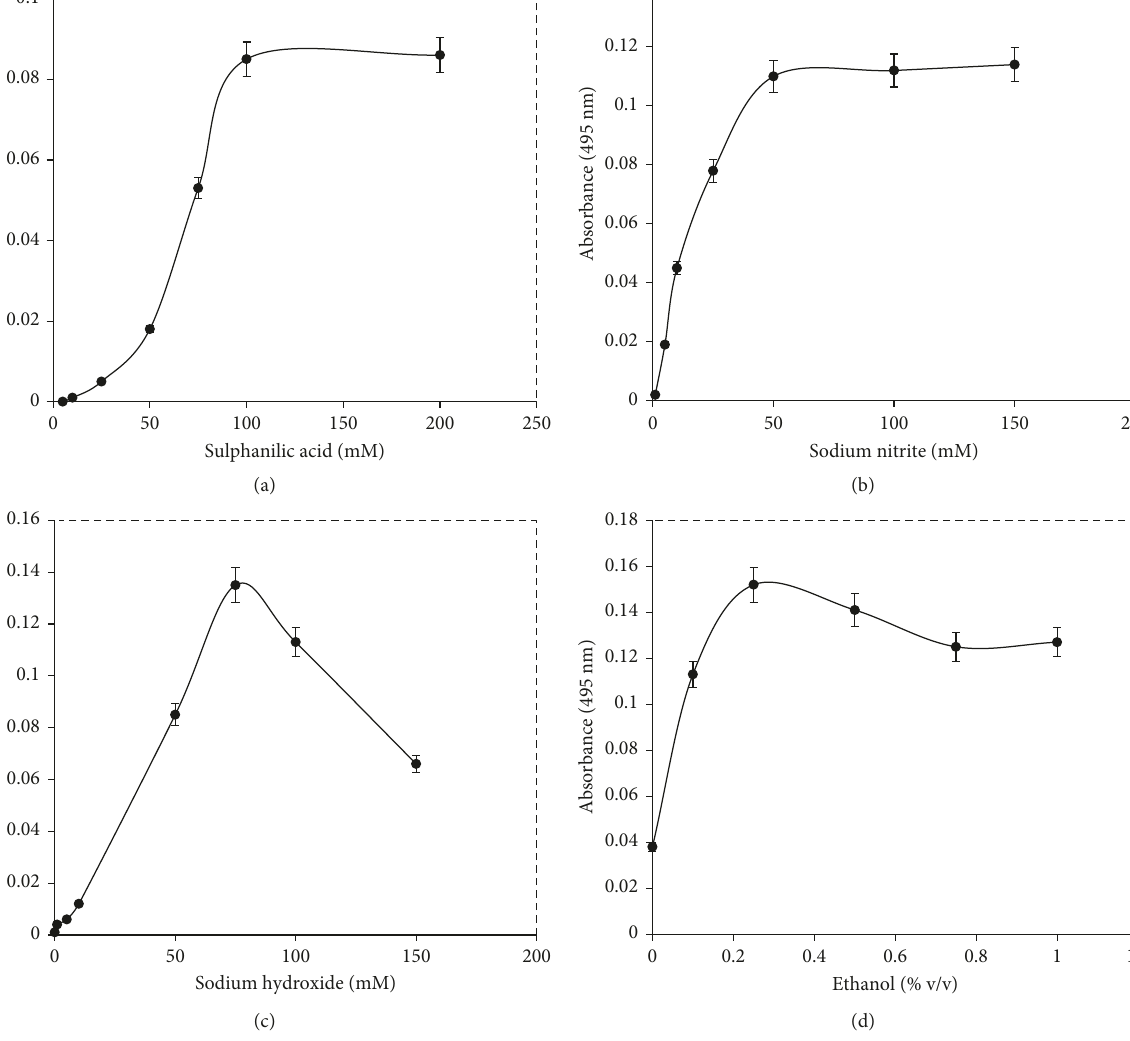
Figure 3: Optimization of reagents concentration. (a) Sulphanilic acid, (b) sodium nitrite, (c) sodium hydroxide, and (d) ethanol. Ex- perimental conditions: flow rate 0.5mL/min, sample loop volume 300 µ L, reaction coil-I length 200cm, reaction coil-II length 150cm, wavelength 495nm, temperature 30 ° C, and ANTU concentration 10